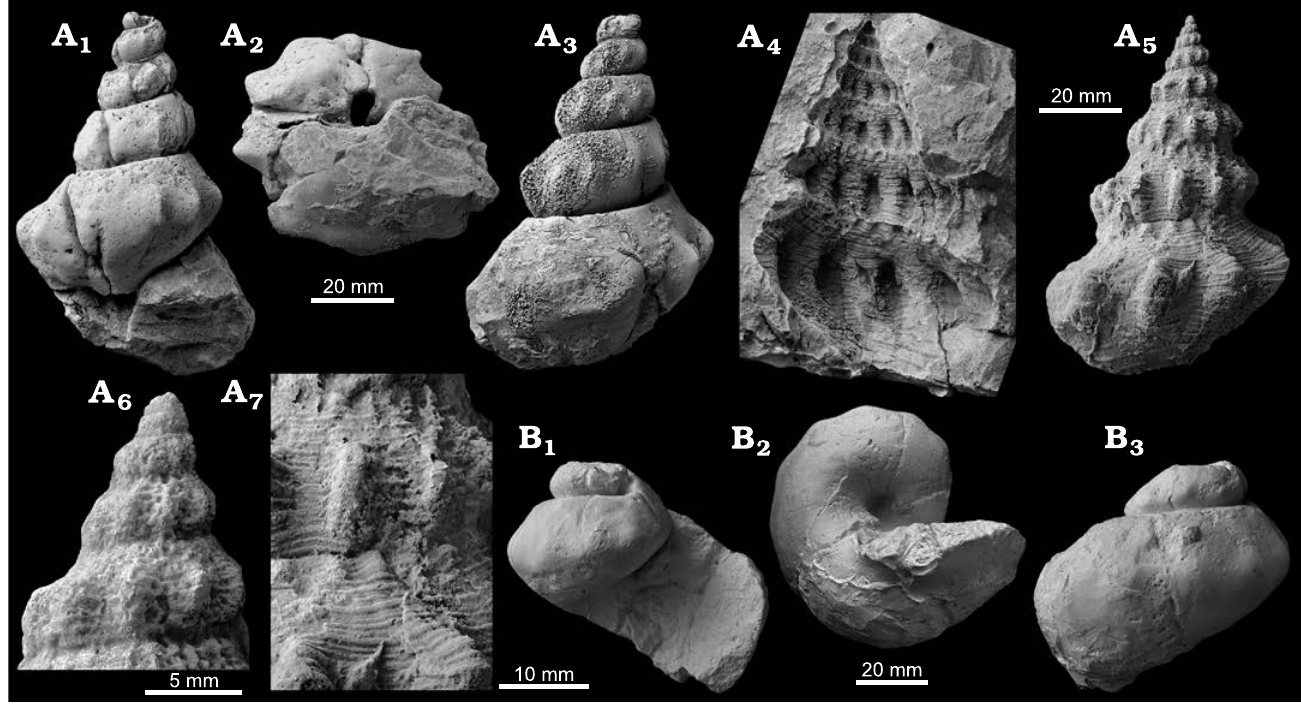
Fig. 3. Zygopleurid? gastropod Ederazyga fanchini gen. et sp. nov.; upper Rhaetian, Villa Edera (Lombardy, northern Italy). A . Holotype MSNVI 042/049, inner mould in apertural (A 1 ), basal (A 2 ), and dorsal (A 3 ) views; external mould in general view (A 4 ), rubber cast of the dorsal view (A 5 ), detail of the apical spire (A 6 ), and detail of the penultimate and last whorls (A 7 ). B . Plaster cast replica of MSNVI 042/049a, inner mould in apertural (B 1 ), basal (B 2 ), and dorsal (B 3 )